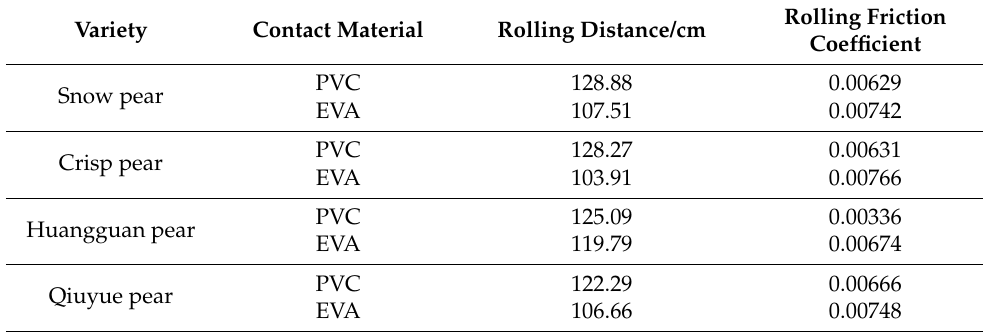
Rolling Friction